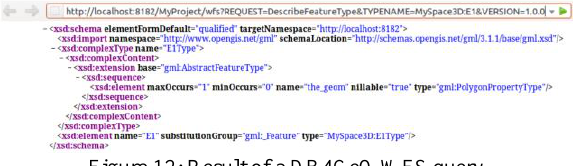
Figure 12: Result of a DB4GeO WFS